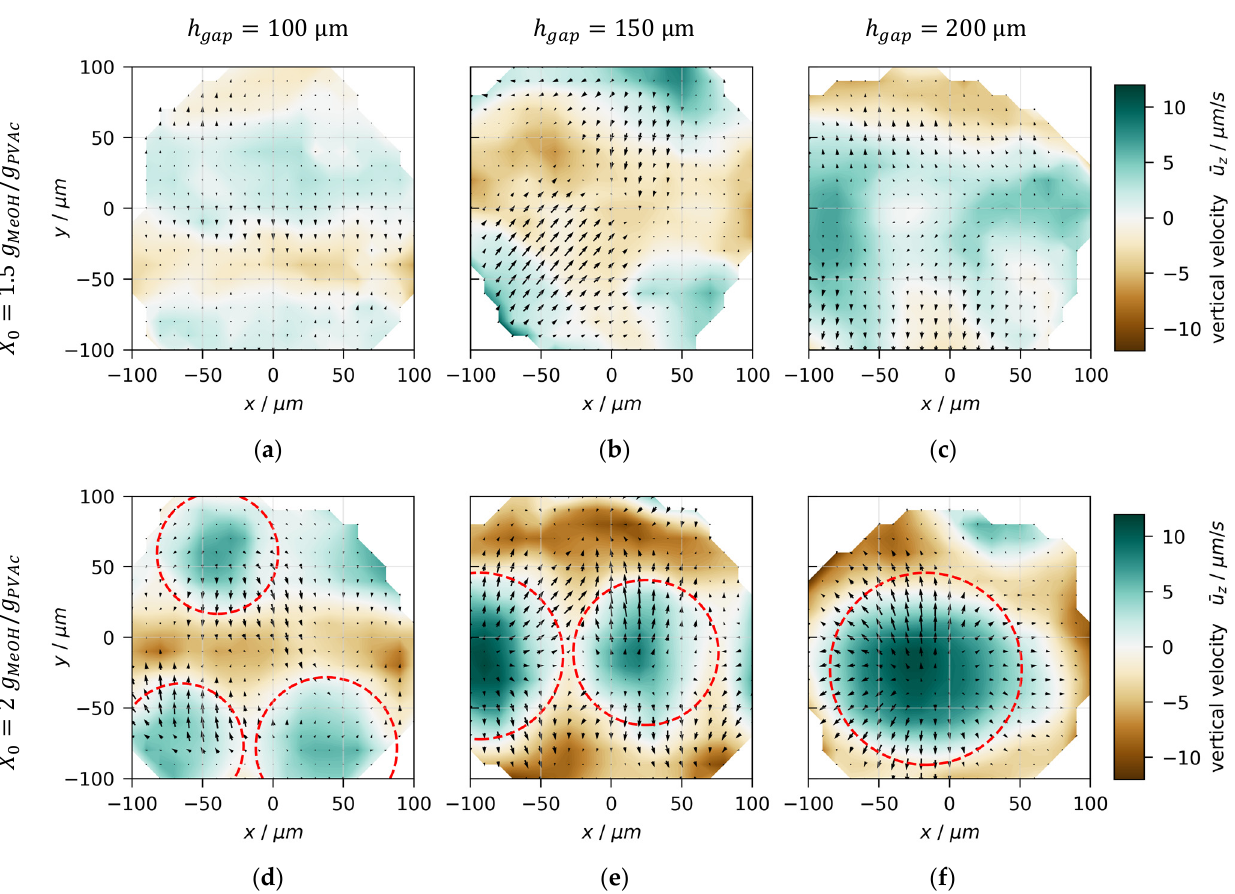
Figure 8. Top-view of flow field in poly(vinyl acetate)-methanol films, drying at T substrate = 20 ◦ C and otherwise ambient conditions. Data at t = 10 s drying time. The colored background shows the height-averaged vertical velocity and the black arrows indicate the lateral velocity at the film surface. The discrete tracer data were interpolated on a regular grid for better visualization. ( a – c ) X 0 = 1.5 g MeOH / g PVAc . ( d – f ) X 0 = 2 g MeOH / g PVAc . The red circles were fitted to white areas, denoting regions of zero height-averaged vertical velocity, in order to extract lateral cell sizes. ( a , d ) h gap = 100 µ m. ( b , e ) h gap = 150 µ m. ( c , f ) h gap = 200 µ